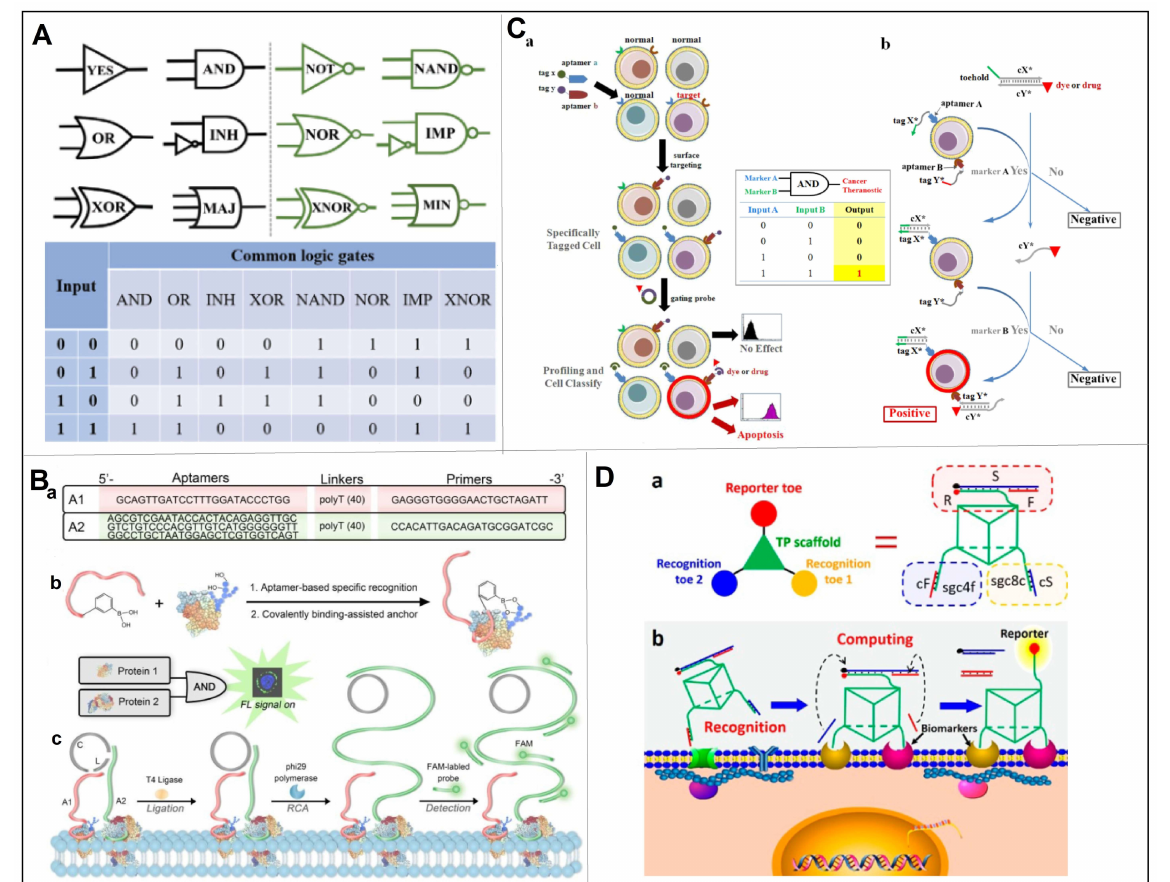
Figure 4. ( A ) Basic logic gates corresponded truth tables reproduced with permission from